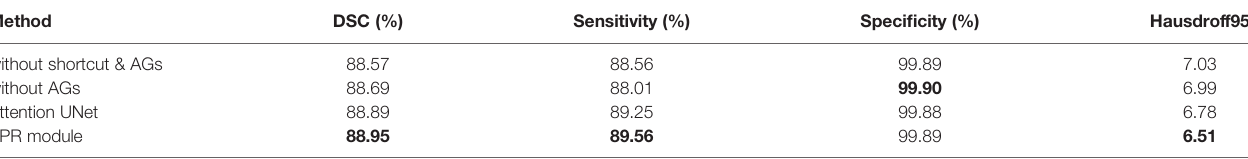
TABLE 3 | Ablation experiment of the APR module without multi-task deep supervision on the BraTS 2020. Method